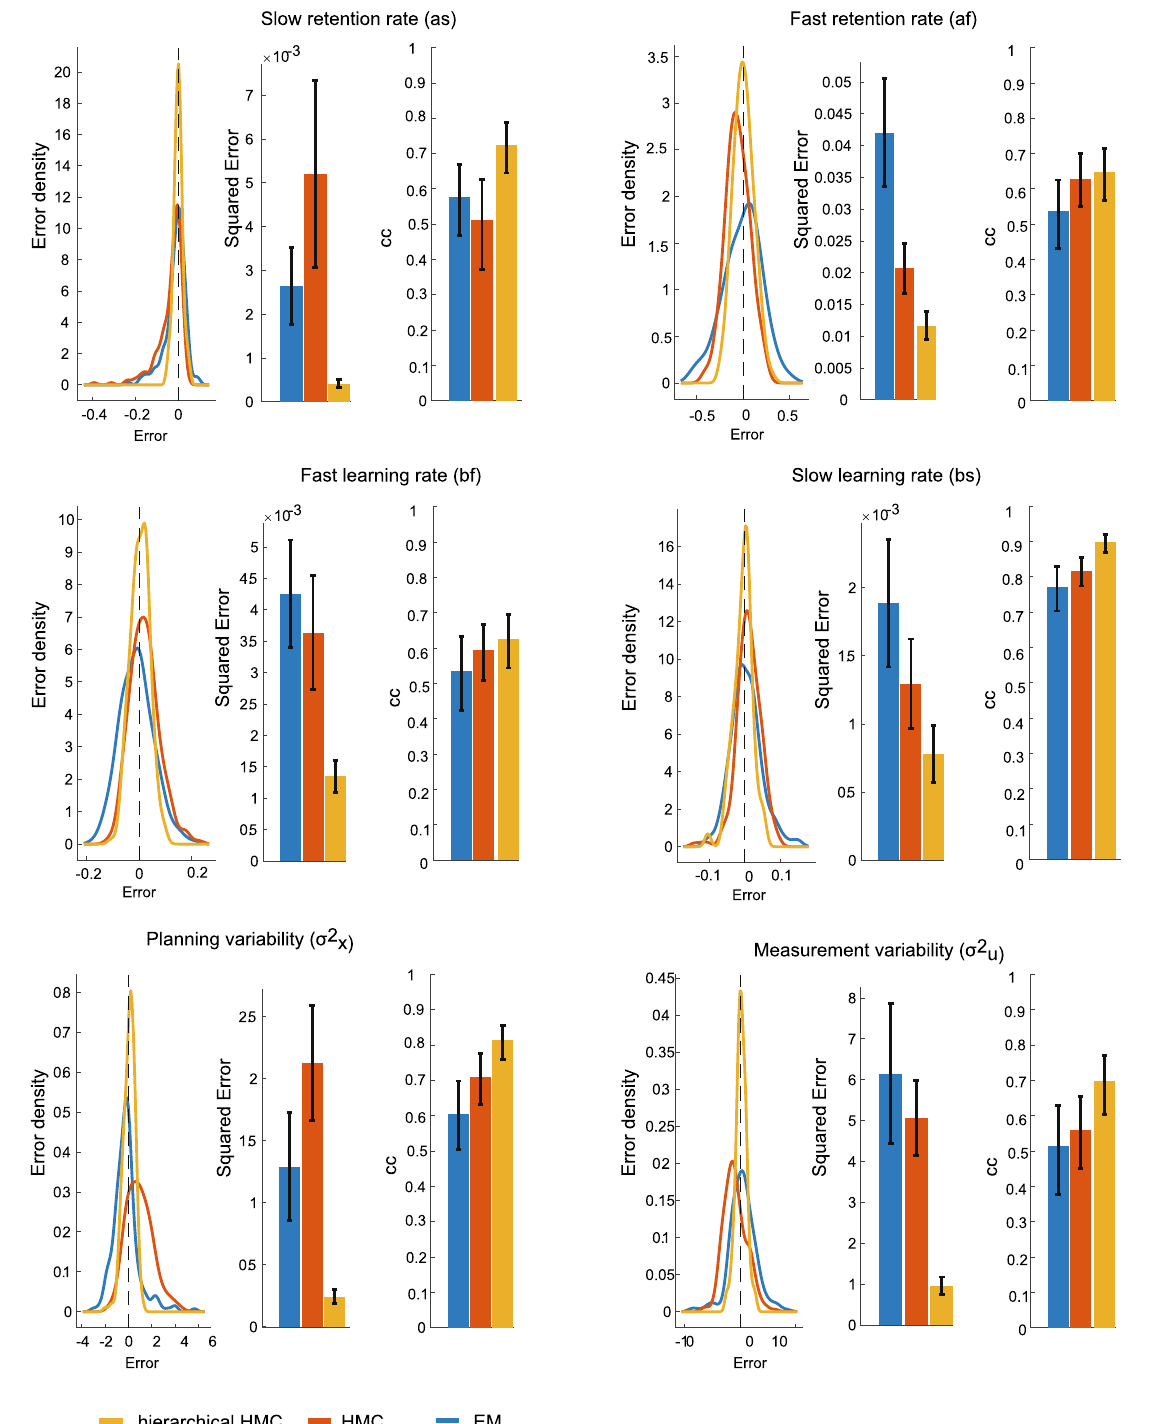
Figure 4. Comparison of hierarchical and non-hierarchical fitting algorithms. Parameter estimation quality for our HMC hierarchical fitting procedure (orange), an HMC non-hierarchical fitting procedure (red), and a EM fitting procedure 45 (blue). For each random parameter setting of the surrogate two-state datasets, we represent the error in parameter reconstruction (estimated minus set parameter) for each fitting procedure, including the distributions of the errors, average and 95% confidence intervals of the squared error; and the correlation (average d 95% CI) between the estimated and set parameters